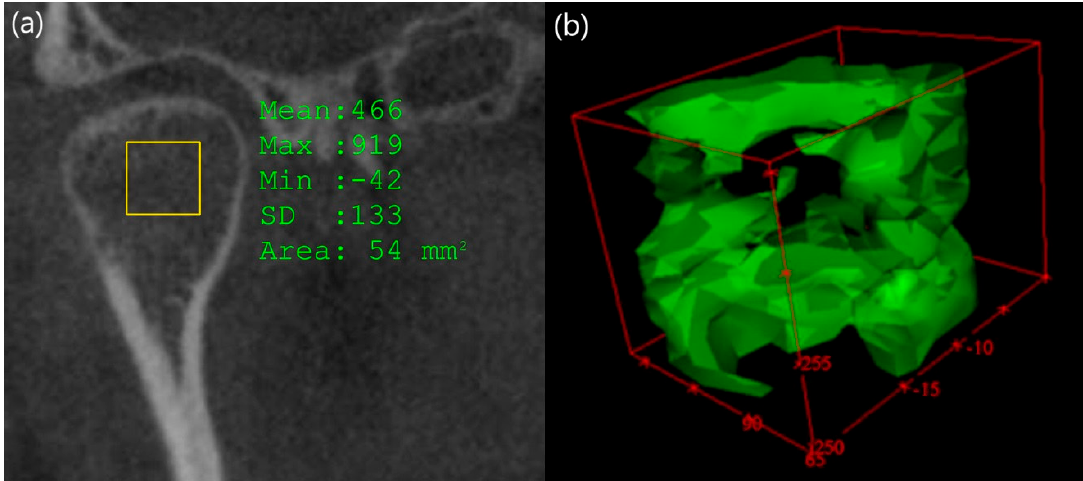
Figure 2. Two methods of trabecular bone density measurement: ( a ) Hounsfield unit, ( b ) trabecular bone microstructure parameters from reconstructed three-dimensional (3D) images. Table 2. Description of trabecular microstructure parameters.